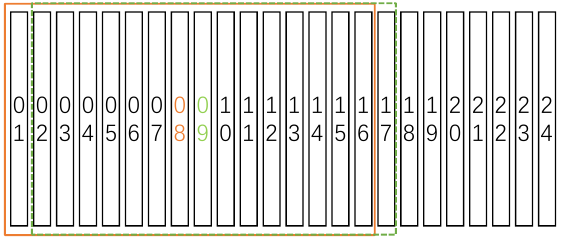
Figure 4. Feature extraction sampling